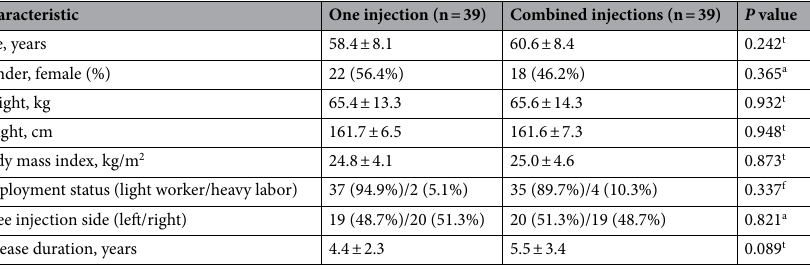
Table 2. Demographic and baseline characteristics of the intention-to-treat population. The values are given as mean ± the standard deviation or number of patients, with the percentage in parentheses. a χ 2 -test. f Fisher’s exact test. t Independent t-test. * P < 0.05.